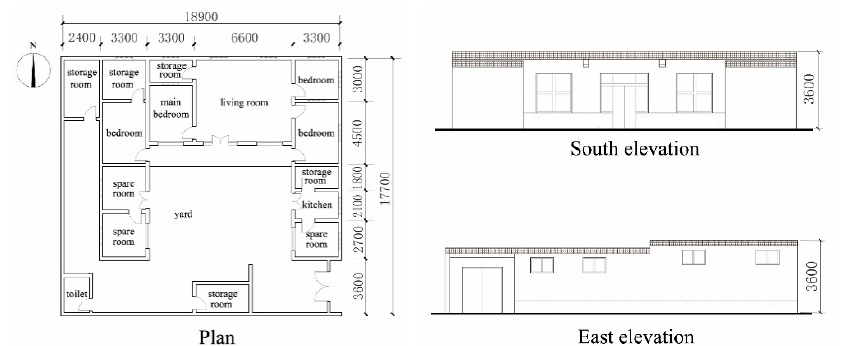
Figure 8. Appearance of Rural House 2.